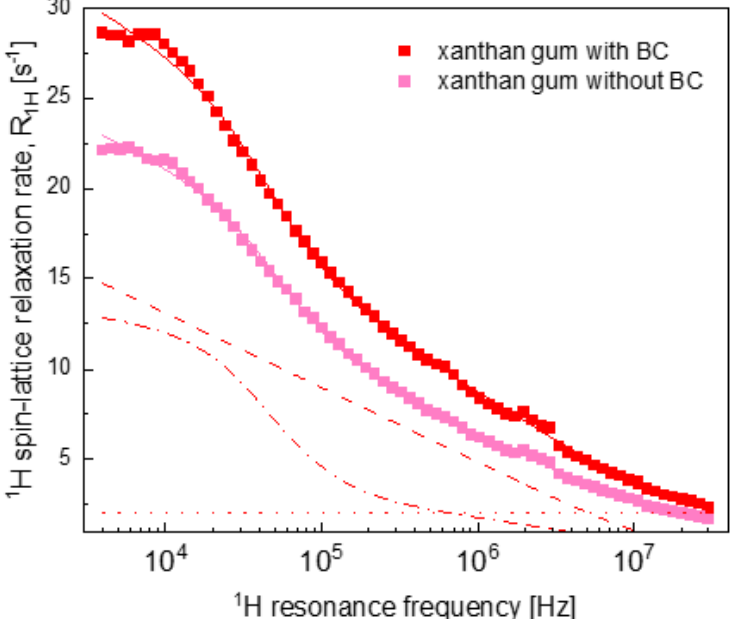
Figure 5. 1 H spin ‐ lattice relaxation data for xanthan gum hydrogels with and without BC. Solid lines—fits ( 𝑅 (cid:2869),(cid:3009) (cid:4666)𝜔 (cid:3009) (cid:4667)(cid:4667) of the data decomposed (for xanthan system with BC) into: 𝑅 (cid:2869),(cid:3009)(cid:3030)(cid:3042)(cid:3041)(cid:3033),(cid:3036)(cid:3041)(cid:3047)(cid:3032)(cid:3045) (cid:4666)𝜔 (cid:3009) (cid:4667) —dashed line, 𝑅 (cid:2869),(cid:3009)(cid:3030)(cid:3042)(cid:3041)(cid:3033),(cid:3036)(cid:3041)(cid:3047)(cid:3045)(cid:3028) (cid:4666)𝜔 (cid:3009) (cid:4667) —dashed–dotted line and 𝐴 —dotted line.